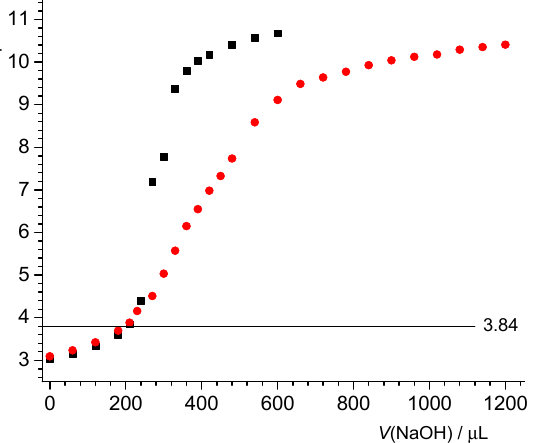
• ) and without ( (cid:4) ) CNT